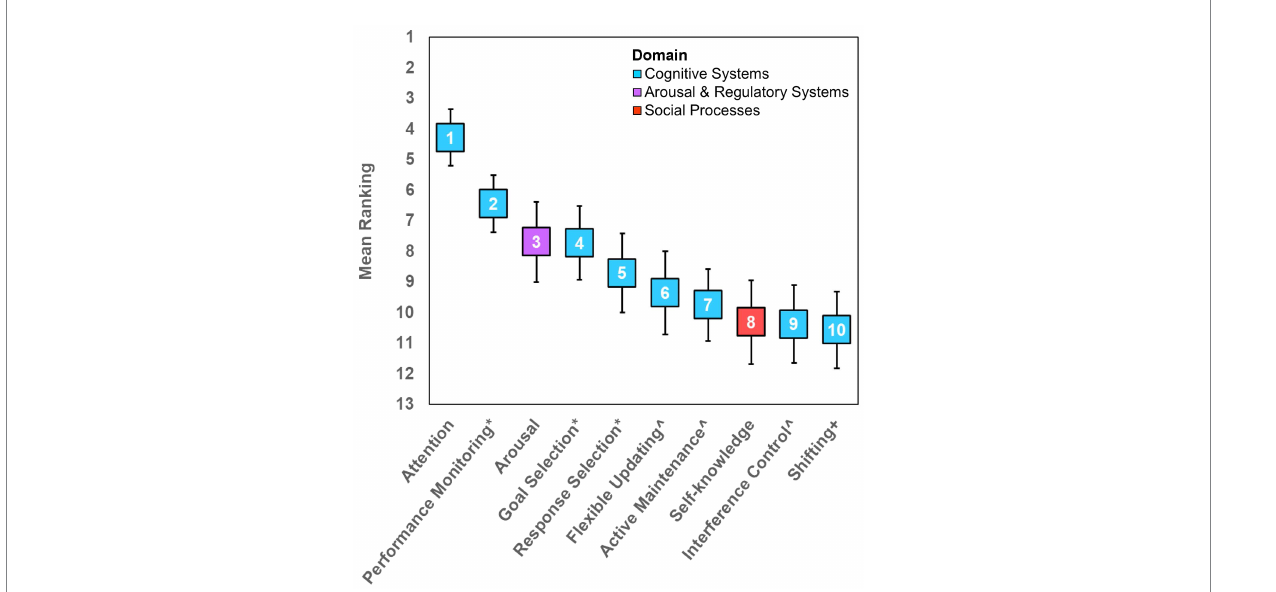
FIGURE 2 Mean ranking of the ten transdisciplinary constructs. Rank order is displayed within the corresponding marker. Error bars represent 95% Confidence Intervals. N.B. * denotes Cognitive Control subconstructs. ^ denotes Working Memory subconstructs. + denotes that Shifting was an expert-suggested construct (considered to belong in the Cognitive Systems Domain). ‘Goal Selection’ = Goal Selection; Updating; Representation; Maintenance. ‘Response Selection’ = Response Selection;